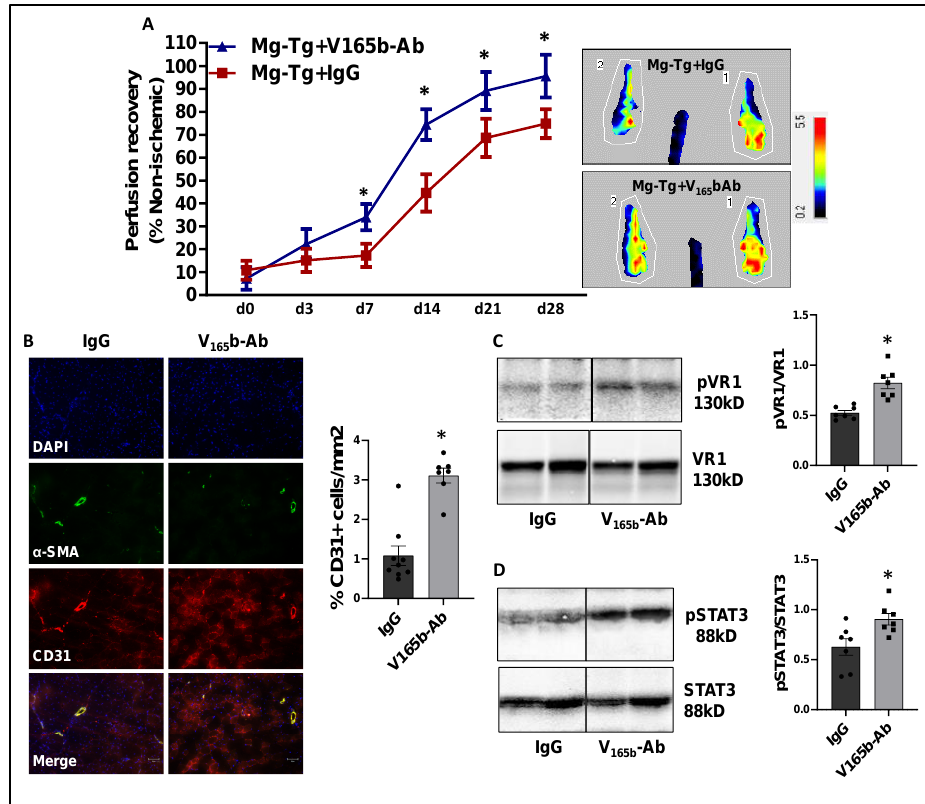
Figure 7. VEGF 165 b inhibition improves perfusion recovery in Mg-Tg mice by activating VEGFR1- STAT3 signaling in experimental PAD. ( A ) Laser Doppler microvascular perfusion imaging of Mg-Tg mice treated with IgG or V 165 b-Ab over the time course of recovery. n ≥ 7. Repeated Measures ANOVA with Dunnett’s post-test. * p < 0.05 considered significant at specific time points. ( B ) Immunohistochemical analysis of CD31 in Mg-Tg mice ischemic gastrocnemius muscle treated with IgG or V 165 b-Ab at day 28 post-HLI. n ≥ 7. Unpaired t -test. ( C, D ) Immunoblot analysis of pVR1/VR1, pSTAT3/STAT3 in Mg-Tg mice ischemic gastrocnemius muscle treated with IgG or V 165 b-Ab at day 3 post-HLI. n = 7. Unpaired t -test. * p < 0.05 considered significant. Data Mean ± SEM.